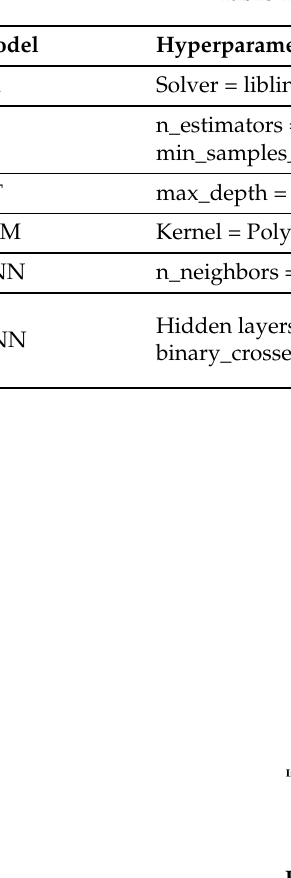
Table 4. List and values of hyperparameters used for machine learning models.